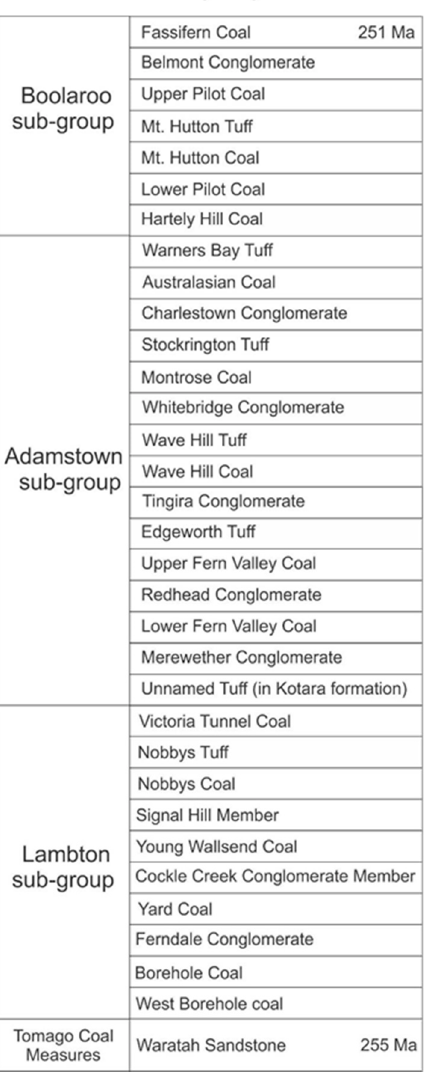
Figure 2. Lithostratigraphic chart of the Northern Sydney Basin illustrating the different sub-groups that form the studied succession [15,21]. The Lambton, Adamstown and Boolaroo sub-groups make up the Newcastle Coal Measures. Each sub-group is internally sub-divided into lithological units that are defined as conglomerates (e.g., Ferndale, Merewether, Redhead and Belmond conglomerate), tuffs (e.g., Nobbys, Unnamed, Edgeworth and Mt. Hutton tuffs) and coal seam (e.g., Borehole, Yard, Nobbys, Upper Ferm and Lower Pilot coal).